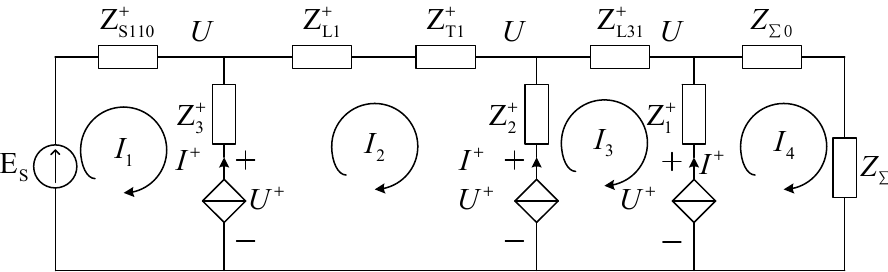
Figure 7. Equivalent circuit diagram with the fault on the tie-line L3.